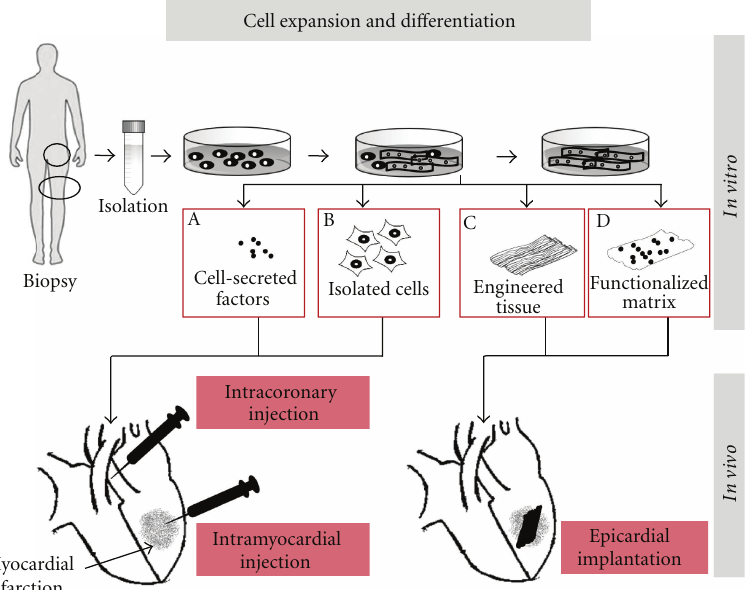
Figure 1: Cell therapy approaches for myocardial infarction: cells are isolated from biopsies, expanded, and eventually di ff erentiated in vitro following specific culture conditions. Conditioned medium containing secreted or lyophilized factors (A) or isolated cells (B) are injected directly within the myocardium or within the coronaries. Further in vitro process from cultured cells enables the development of structured engineered muscle tissue with or without contracting properties that can be directly sutured or glued at the surface of the infarct (C). Functionalized matrix combining biologically active factors and engrafted cells (D) represents a more sophisticated